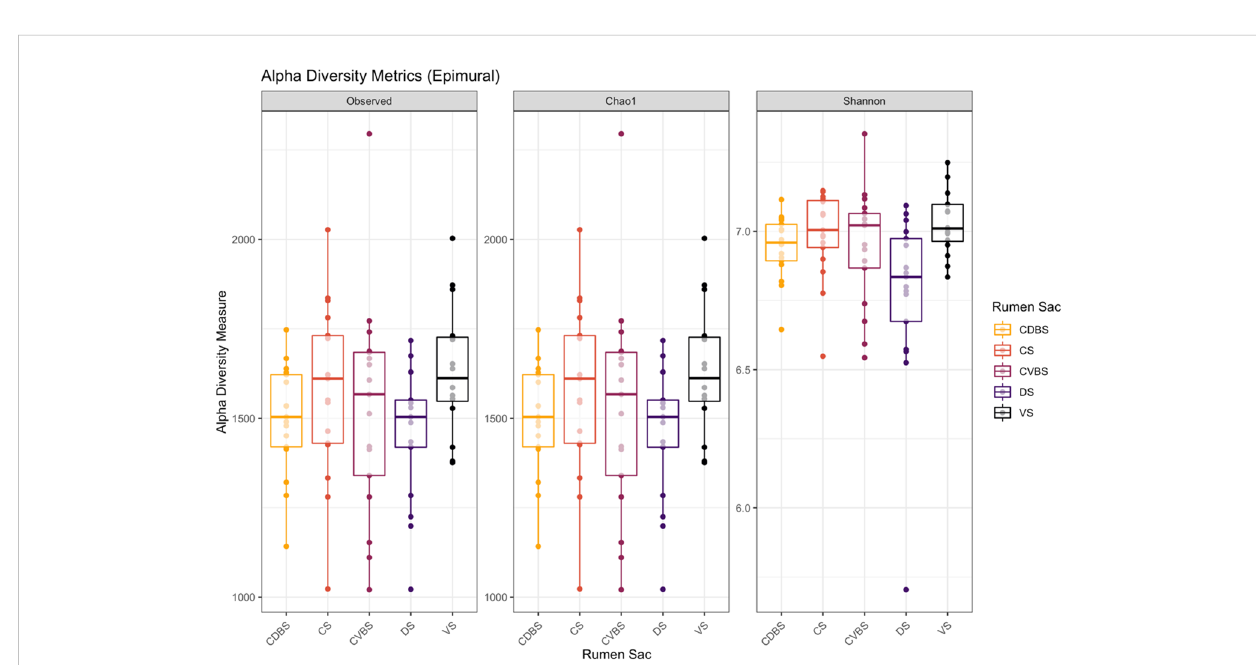
FIGURE 9 Alpha diversity metrics in the epimural fraction among the fi ve rumen sacs. Alpha-diversity metrics for the epimural bacterial communities among each of the fi ve rumen sacs. Measures include observed ASVs (richness), Chao1 (expected richness), and Shannon diversity index (richness and evenness). The CDBS is in orange, CS is in red, CVBS is in light purple, DS in dark purple, and VS is in black. Signi fi cance was determined at P < 0.05 in the measure of Shannon diversity. With the removal of singletons during data analysis, the Chao1 measurement may appear similar to the observed measurement. No signi fi cance was determined for the other two measurements (P > 0.05).